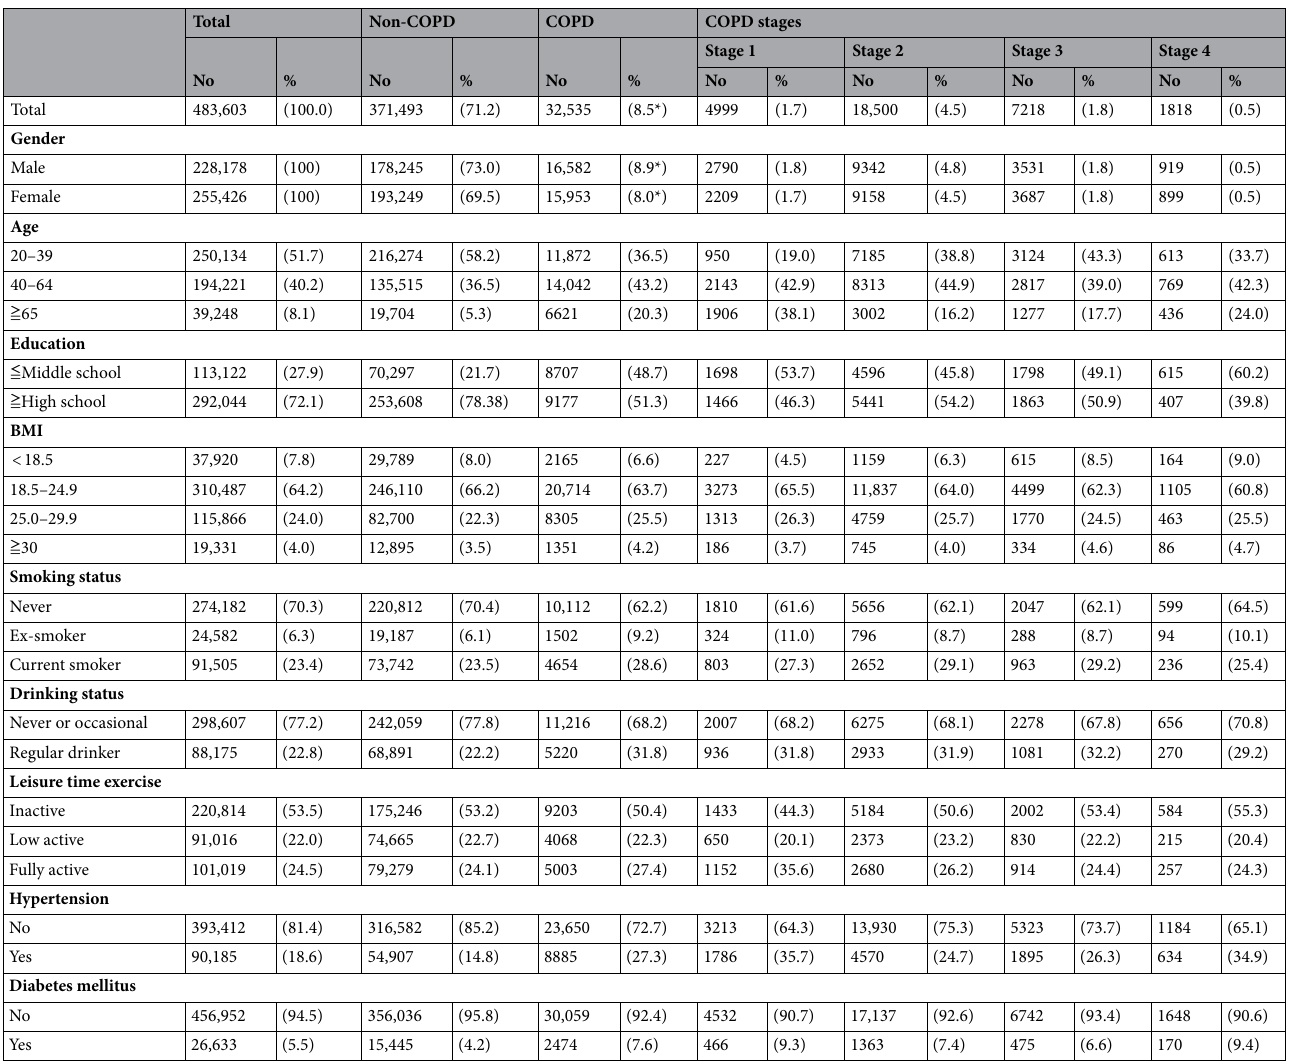
Table 1. Characteristics of the cohort by COPD status. All percentages are calculated within the same subgroup by different characteristics except the first row, which is percentage of subgroup by total population. *Gender- and age-adjusted national prevalence. Age adjusted means that the prevalence of the present cohort has been adjusted by the weight of average age in a five-year range according to 2017 Report of Ministry of the Interior, Taiwan.